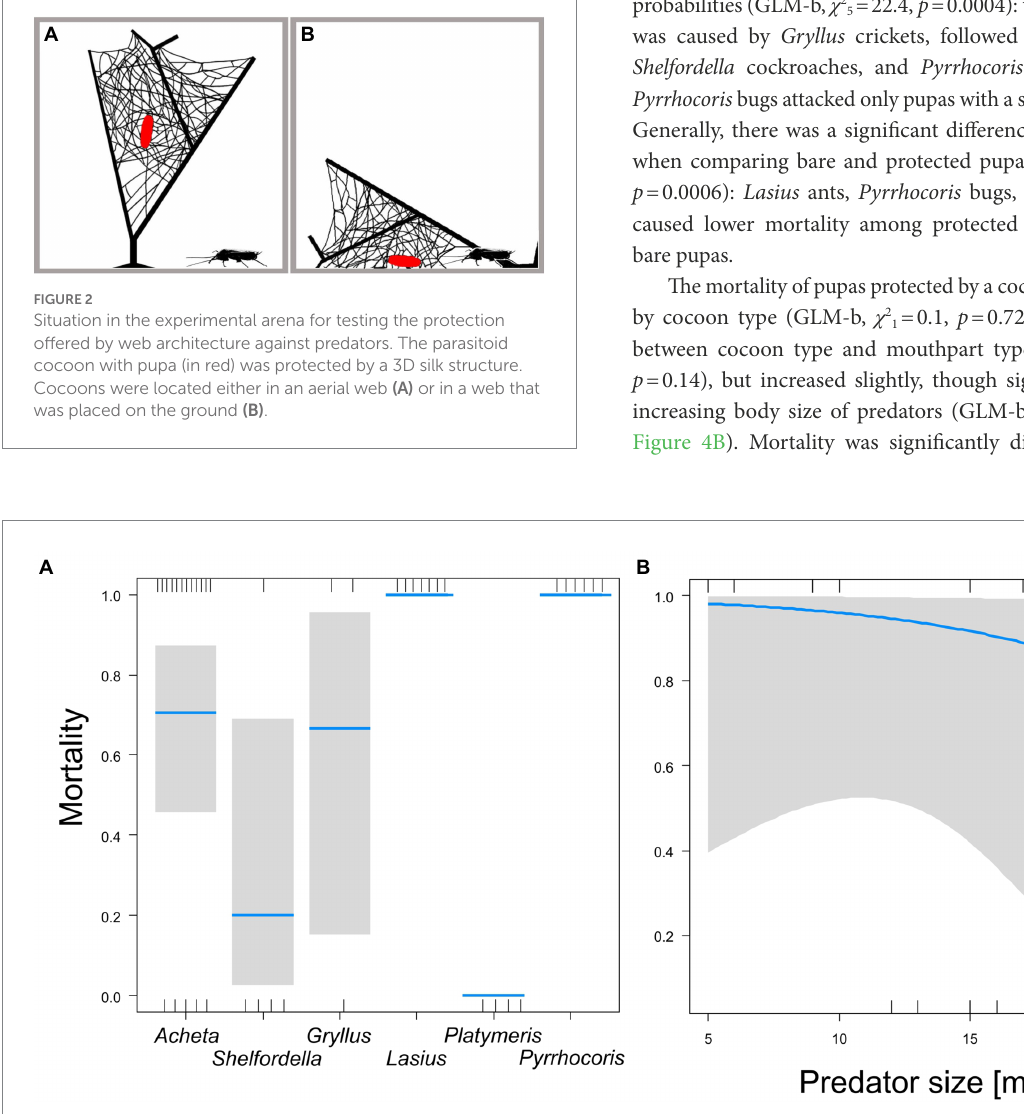
FIGURE 3 Comparison of bare pupa mortality caused by six predators (A) ; the effect of predator size on pupa mortality (B) . Blue lines (A) are estimated means, gray bars are 95% confidence intervals of the mean. The blue line (B) is the estimated exponential model, the gray area is the 95% confidence band of the model. Marks on the horizontal axes represent surviving (upper axis) or dead individuals (lower